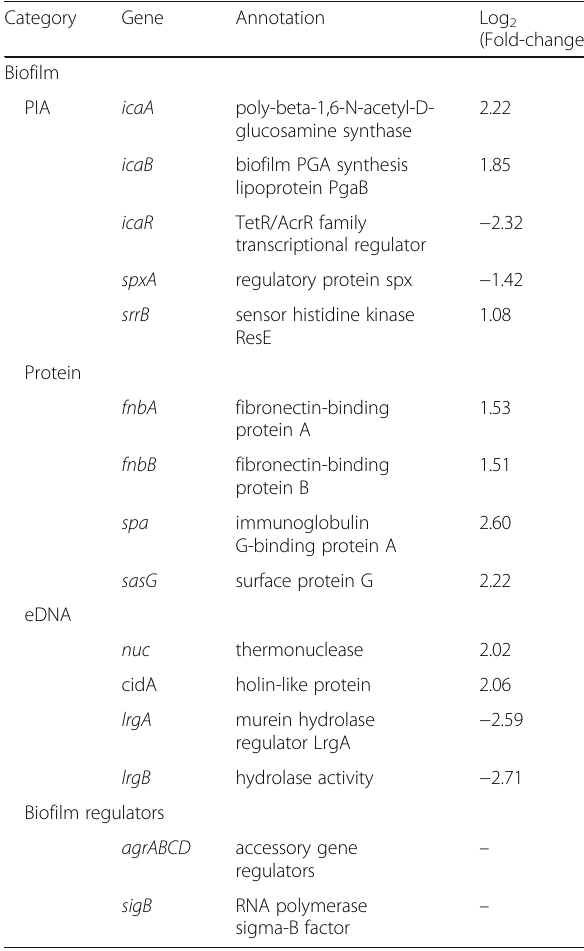
Table 2 Expression fold changes of S. aureus ST1792 biofilm related genes in berberine